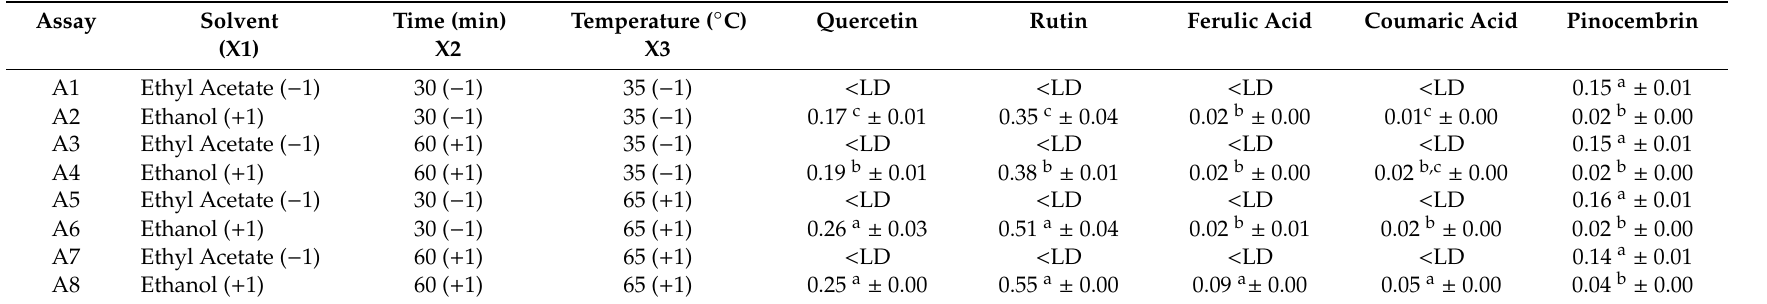
Table 1. The phenolic compounds content (mg / g) by HPLC of Tabernaemontana catharinensis leaves